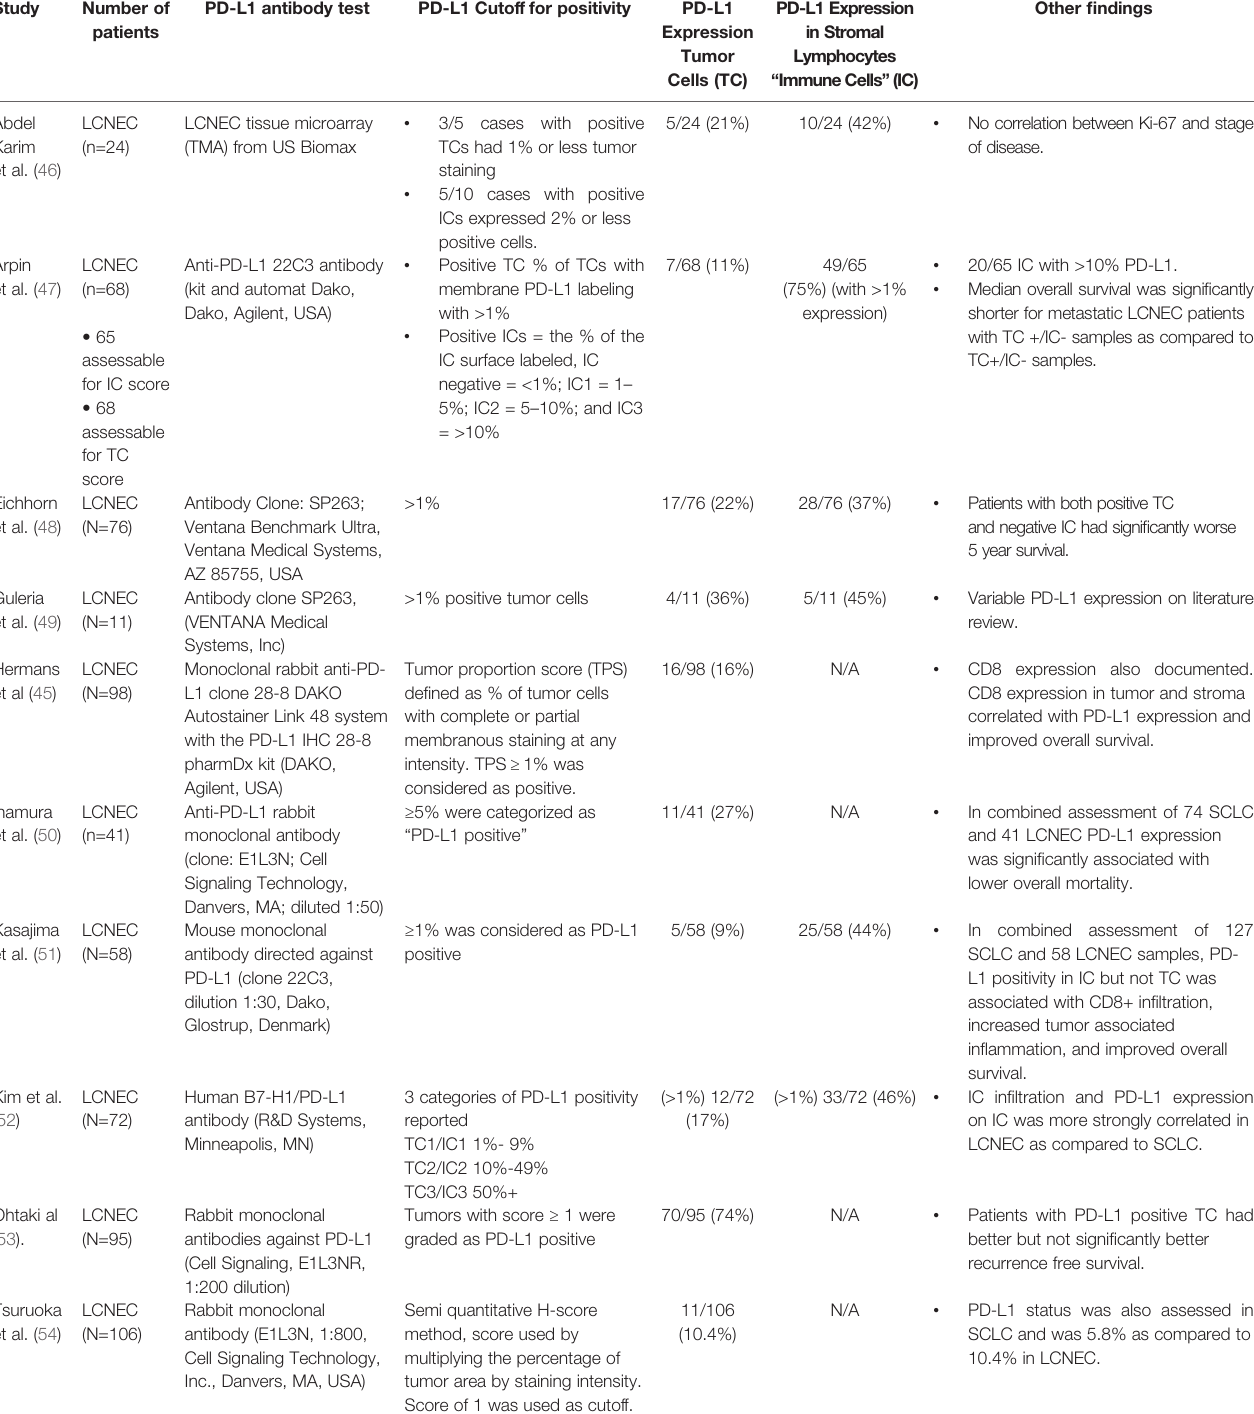
TABLE 3 | Key papers describing PD-L1 expression in pulmonary